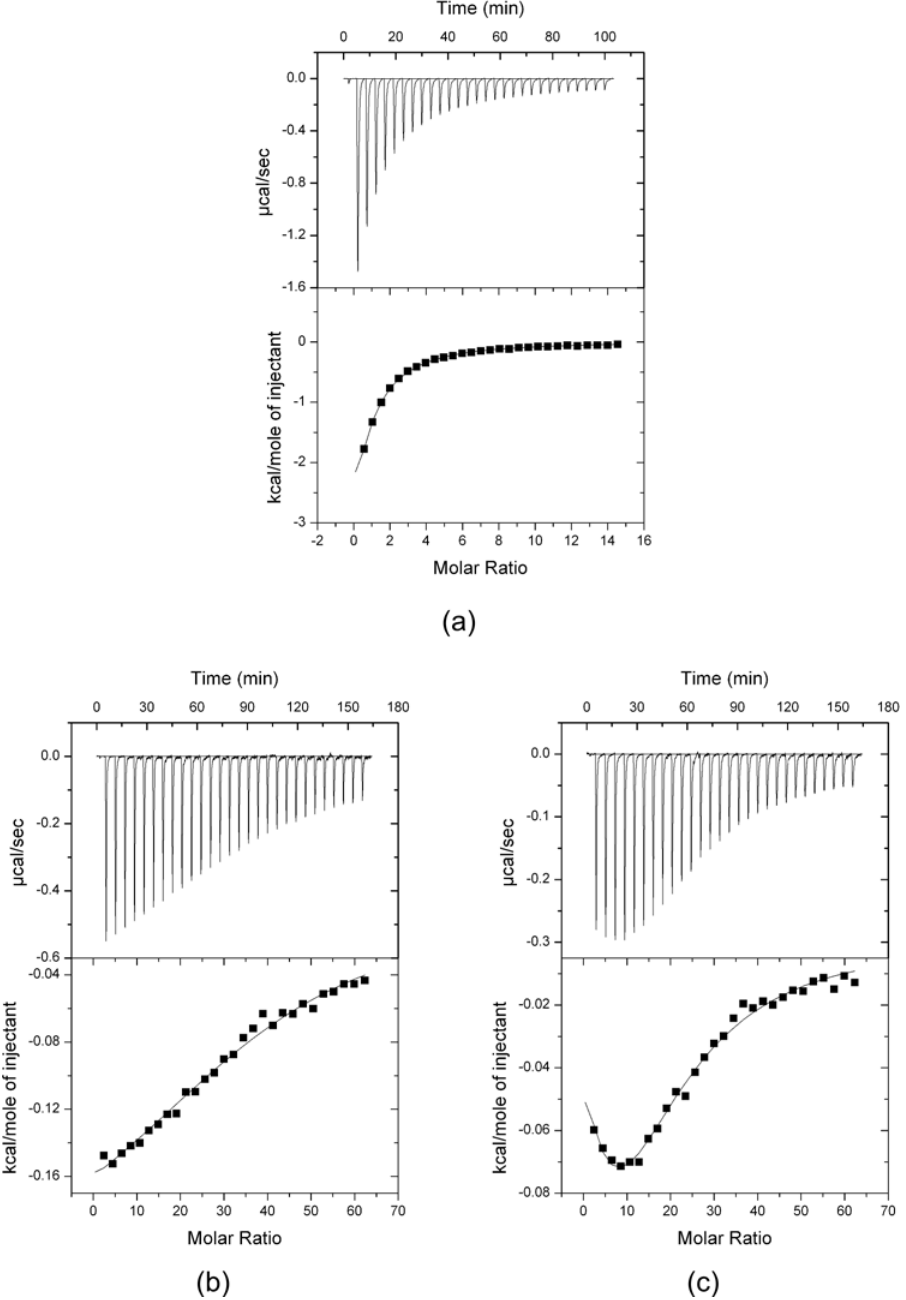
Fig 3. ITC data. Titrations of D -Phe (a) and D -Trp ((b), (c)) into a cell containing 5 μ M Mtu DAH7PS tetramer, corrected for heats of dilution. (a) D -Phe (syringe concentration 3 mM) titration into a cell containing ± 5 μ M. (b) D -Trp (syringe concentration 12 Mtu DAH7PS: fit of a one-site model to the data gives a K d of 93 mM) titration into a cell containing Mtu DAH7PS: fit of a one-site model to the data gives a K d of 700 ± 150 μ M. (c) D -Trp (syringe concentration 12 mM) titration into a cell containing Mtu DAH7PS in the presence of 200 μ M L -Phe: fit of a sequential two-site model to the data gives dissociation constants of 550 ± 60 μ M and 1500 ± 330 μ M.